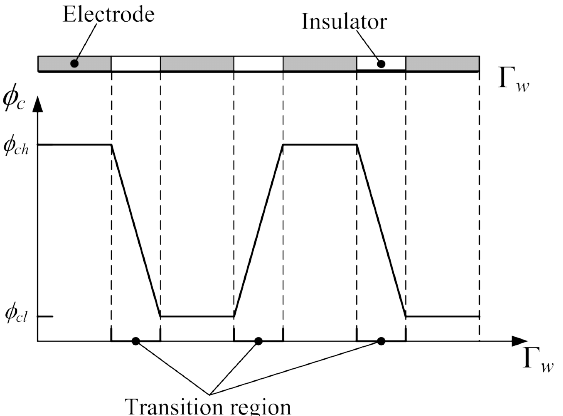
Figure 2. Schematic for the electrode and the corresponding external electric potential at the sidewall of the electroosmotic